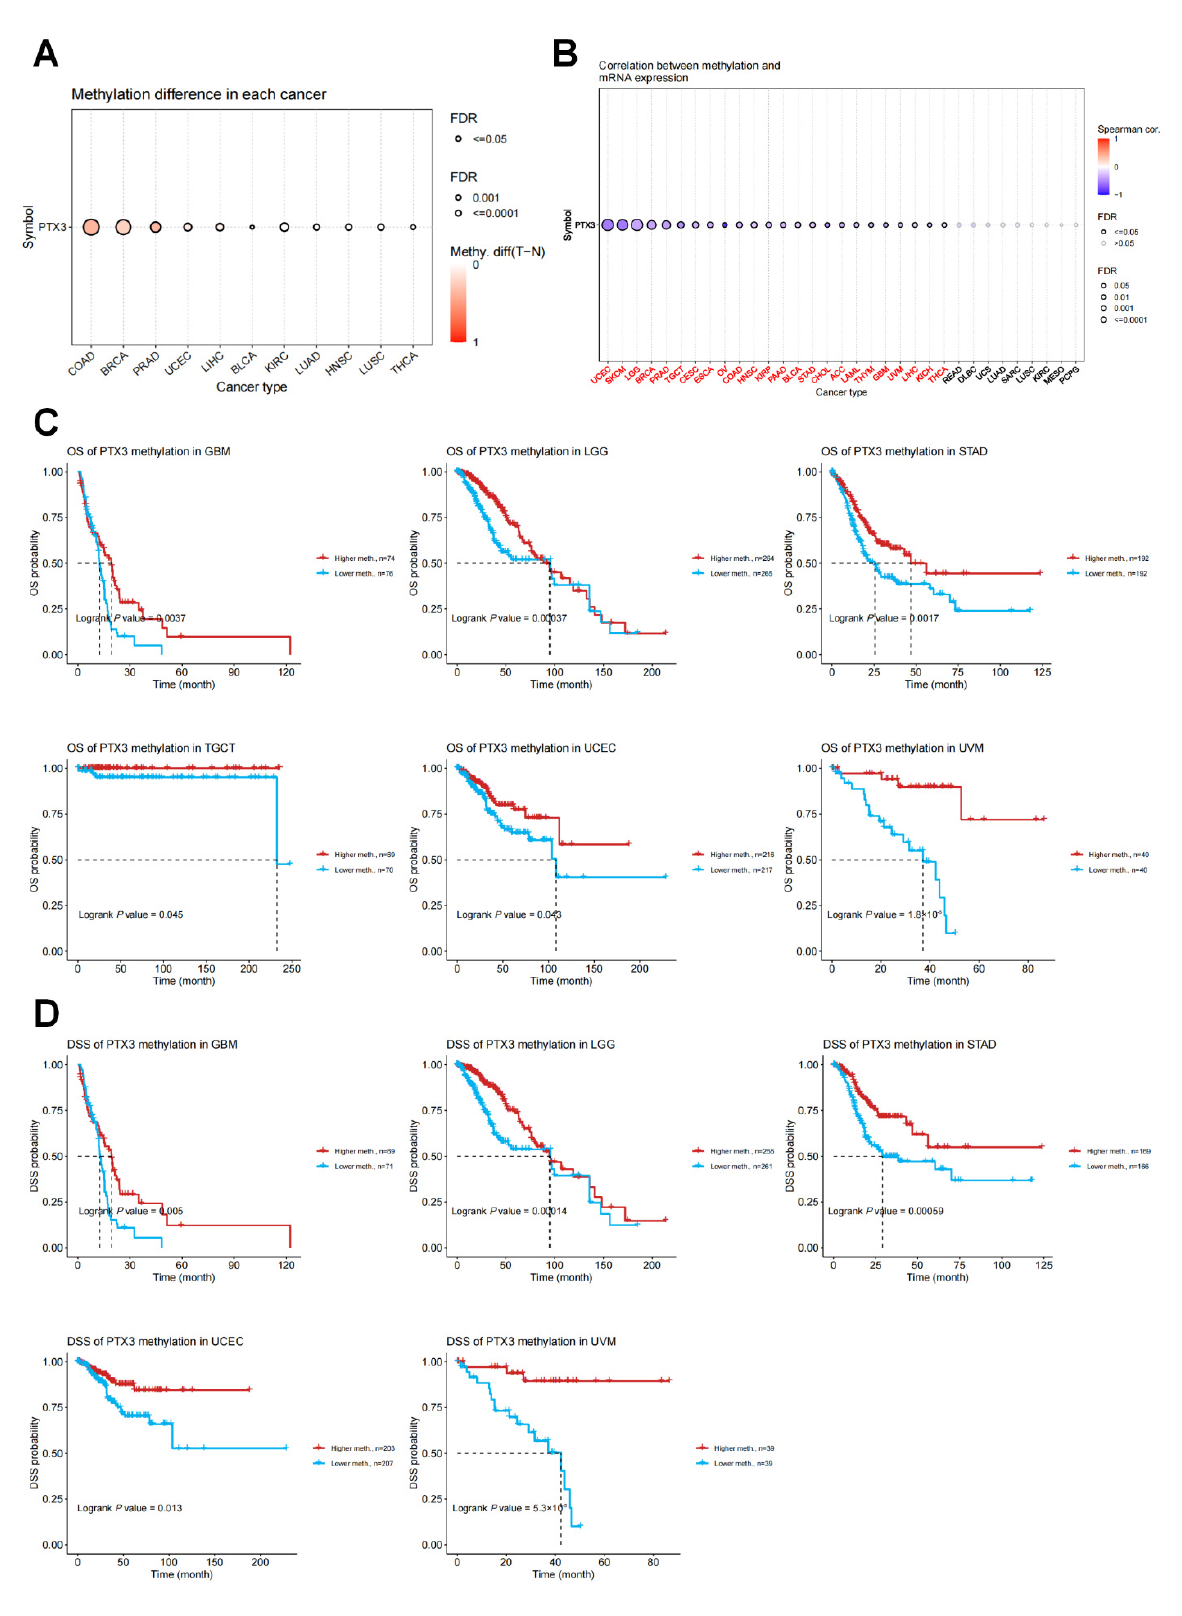
Figure 5. Methylation analysis of PTX3: ( A ) PTX3 methylation differences in pan-cancers; ( B ) the correlations between PTX3 expression and methylation in pan-cancers; ( C ) KM curves of the association between PTX3 promoter methylation and OS in cancers; ( D ) KM curves of the association between PTX3 promoter methylation and DSS in cancers.